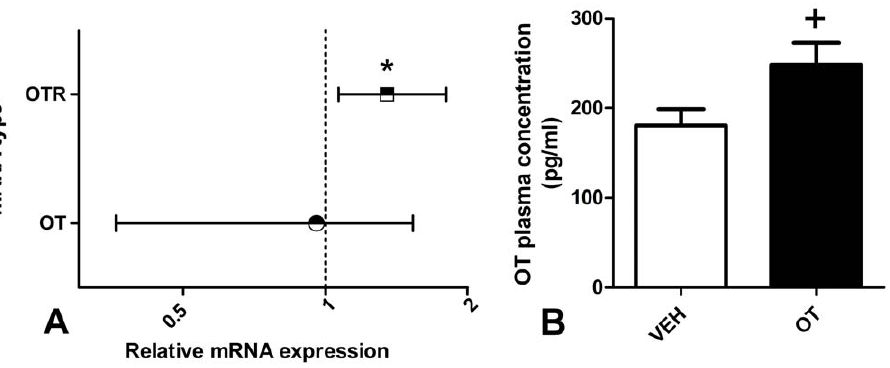
Figure 7. RT-PCR and ELISA. Results from the RT-PCR and ELISA conducted on the 10 rats (5 OT, 5 VEH) randomly selected 21 days after the cessation of 10 consecutive days of once per day treatments with either 1 mg/kg OT or equivalent VEH saline. A. Fold change ( 6 SE) in OT and OTR mRNA expression in the OT pre-treated subjects compared to VEH. B. Mean ( + SEM) blood plasma concentration of OT (pg/ml) in the OT and VEH pre- treated subjects. *Significant fold change, p , 0.05. + Trend towards significant difference compared to VEH,